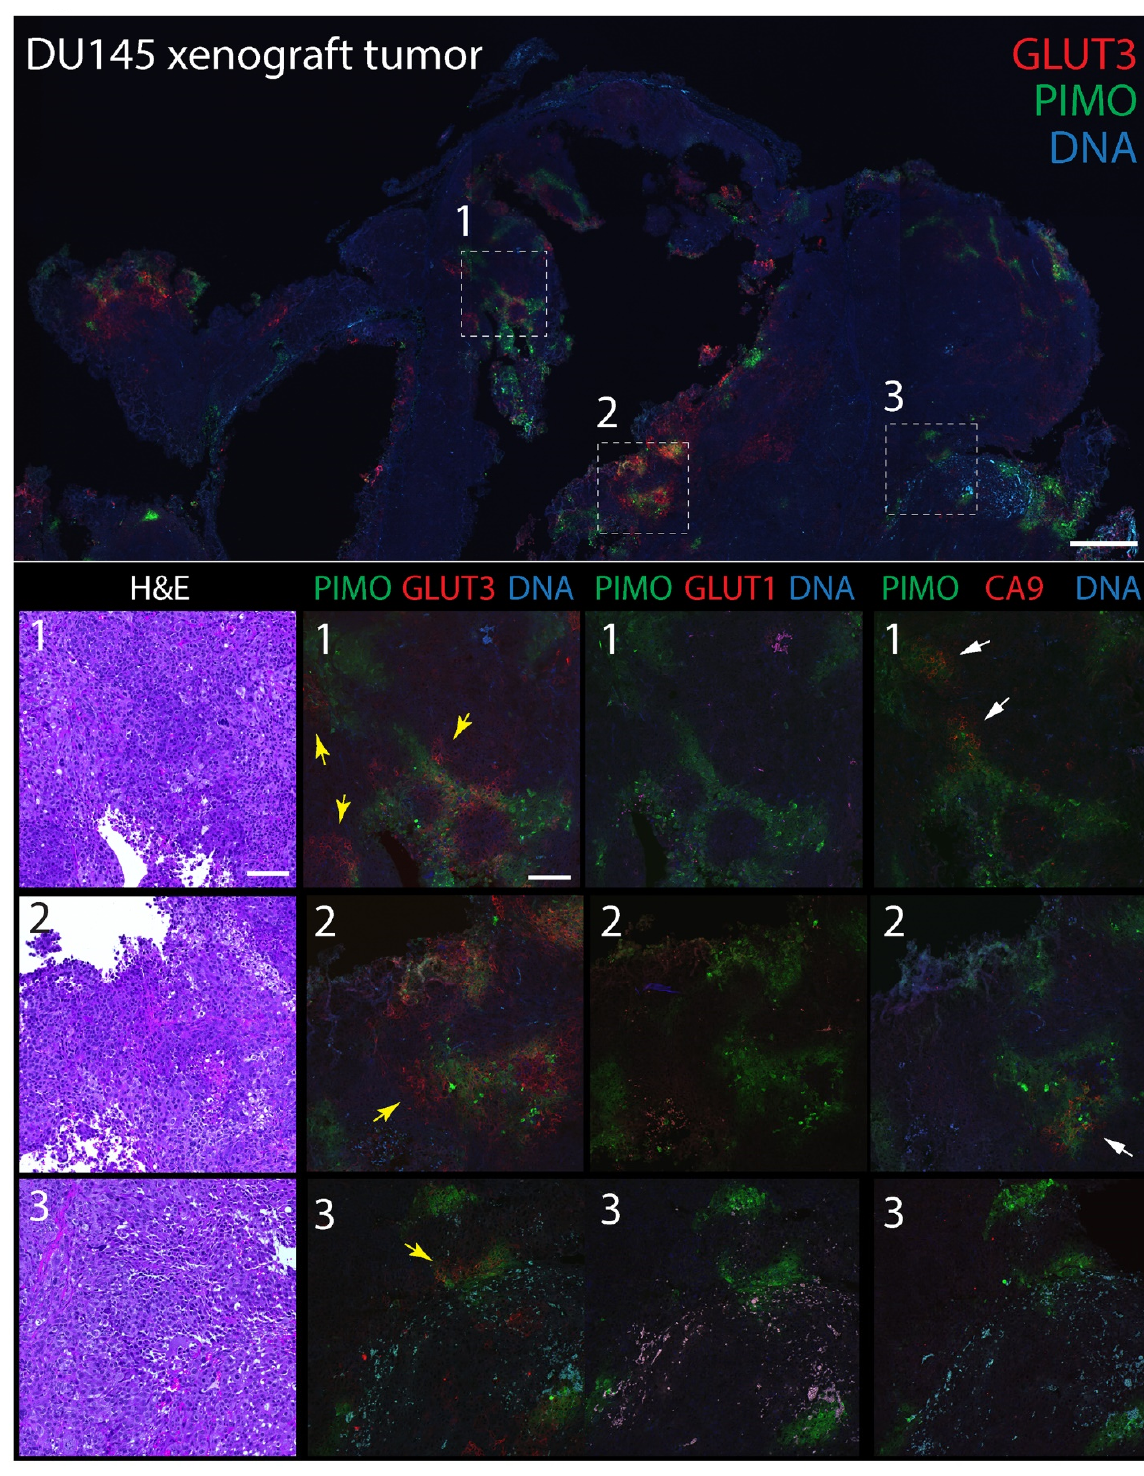
stained for hematoxylin and eosin (H&E), PIMO (green), and GLUT3, GLUT1 or CA9 (red) as indi- cated. Concentrations of GLUT3 (yellow arrows) and CA9 (white arrows) that juxtapose with PIMO are marked. Dashed white boxes show GLUT3 concentrated at the plasma membrane in tumor cells (insets). Scale, 100 μ m.